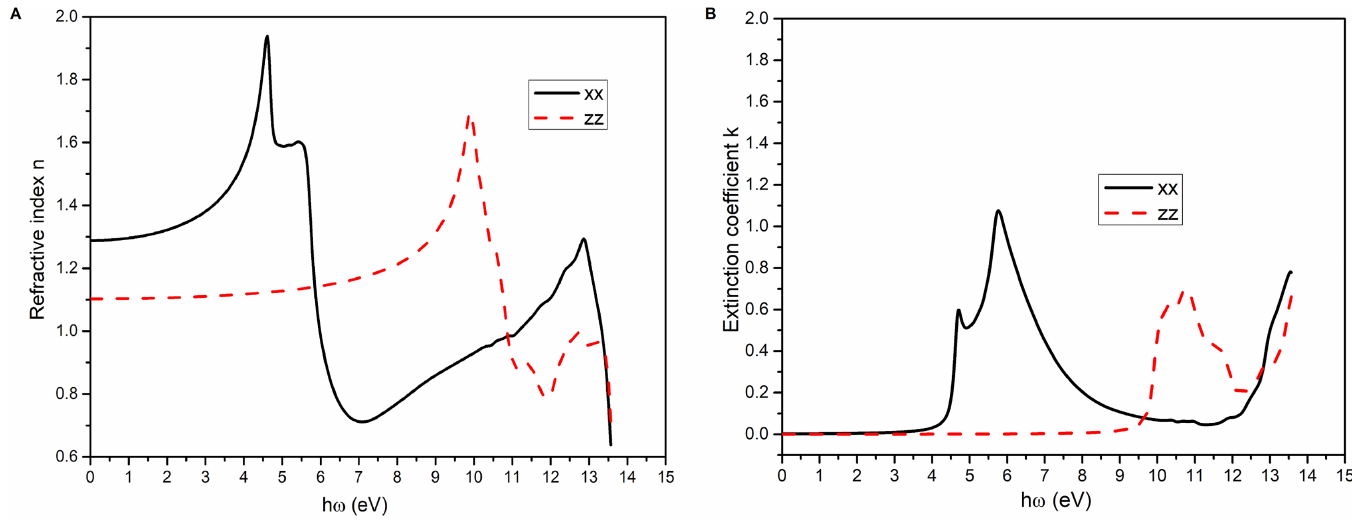
Figure 4 The refractive index. (A) The refractive indices in the xx and zz directions for ML h-BN. (B) The extinction coef fi cients in the xx and zz directions for ML h-BN.